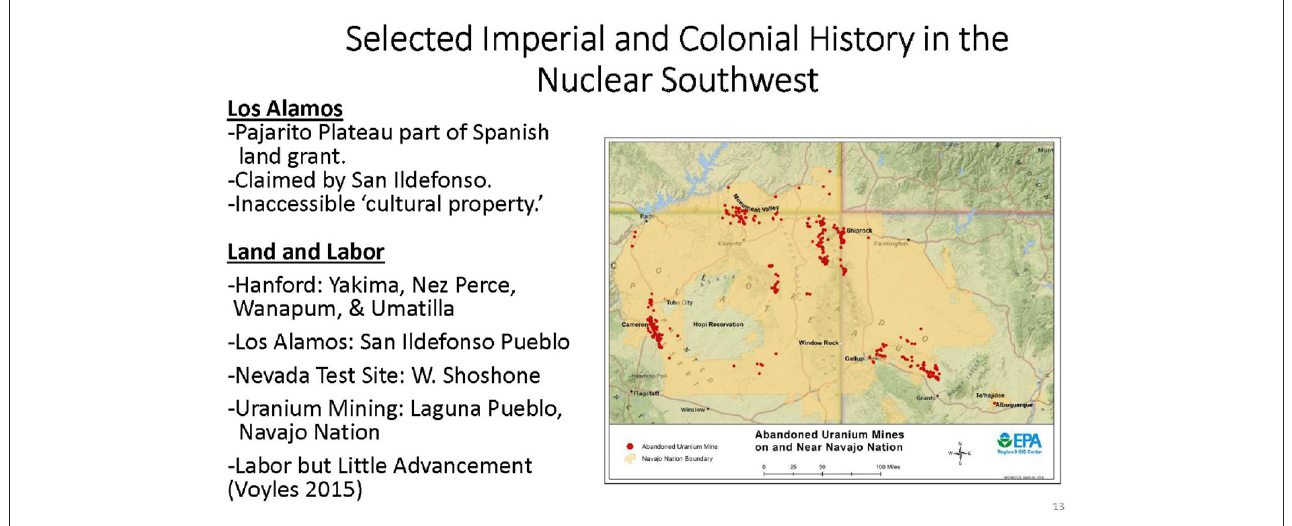
FIGURE17 Slide outlining imperial and colonial history in the nuclear southwest. W11L22.